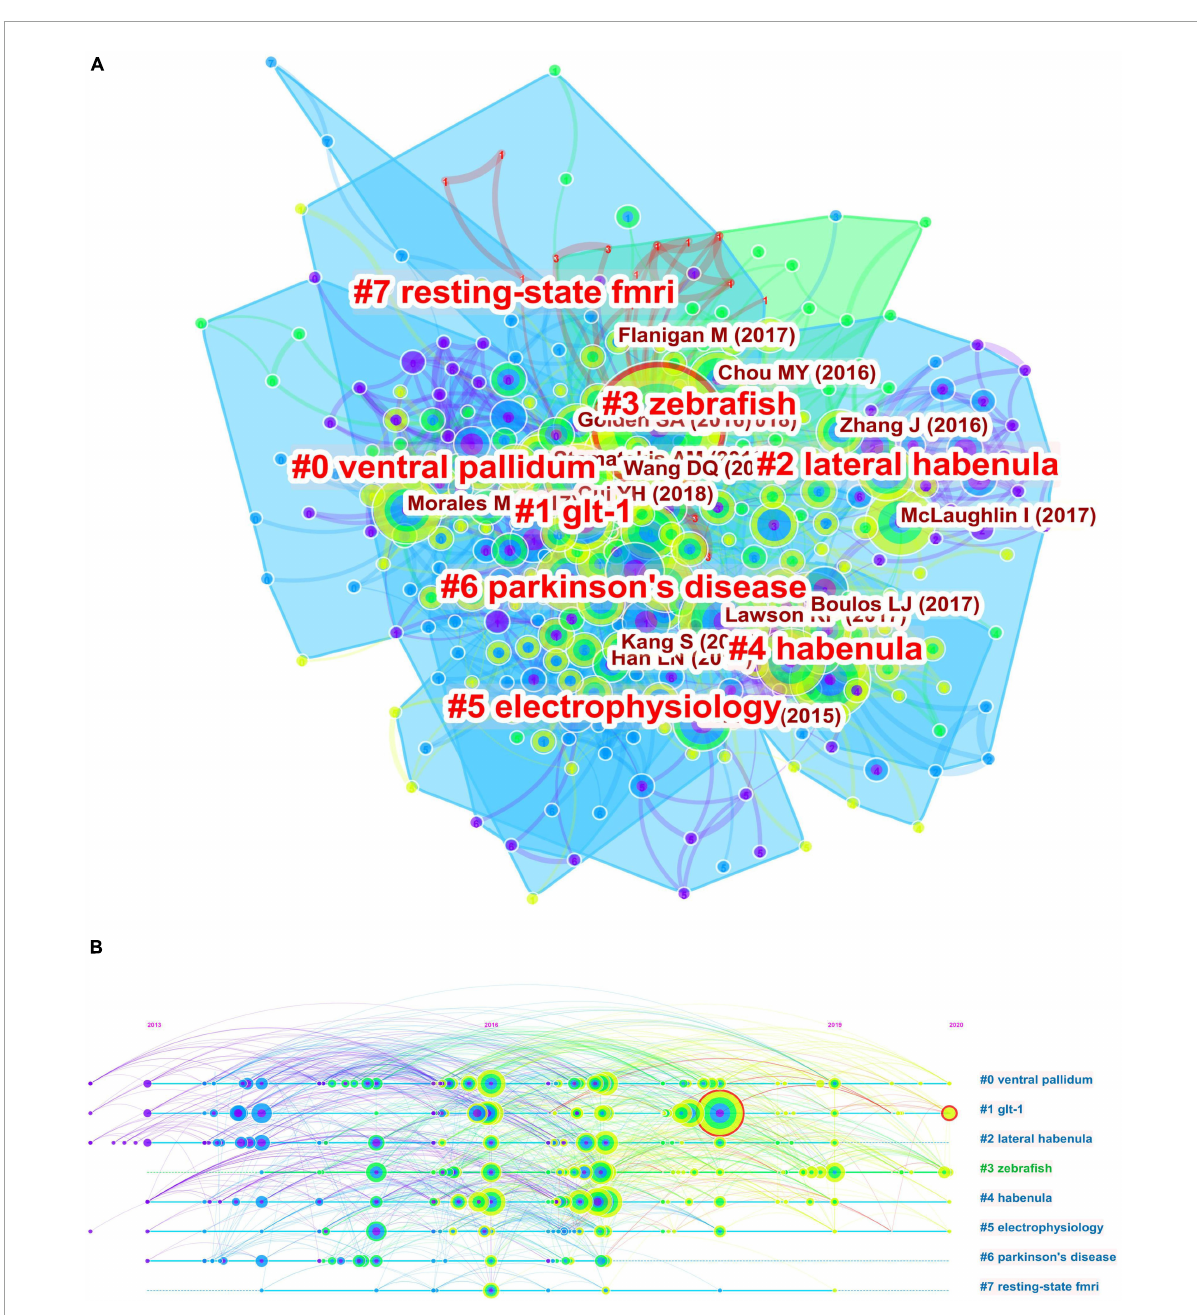
FIGURE5 Co-citation analysis of publications from the past 5 years. (A) Co-citation clustering of references on the habenula. (B) The timeline view of co-citation clusters with cluster labels shown on the